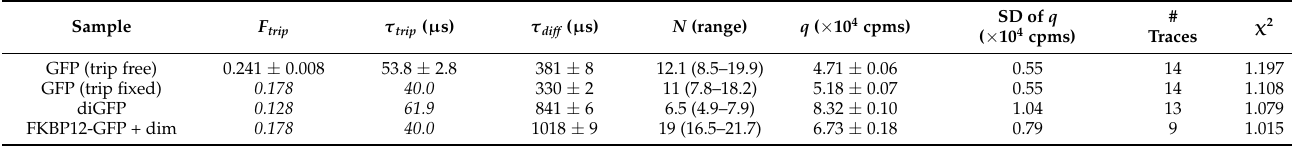
Table 3. Global analysis results of single cells.